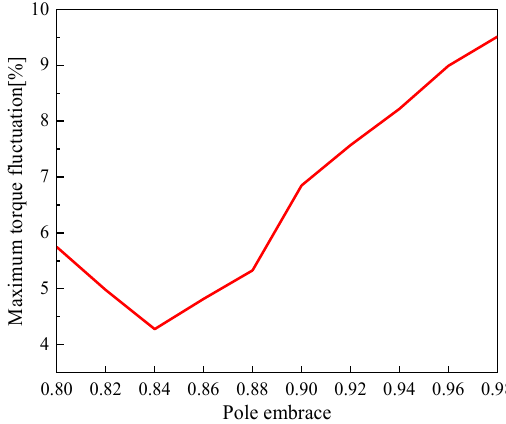
through parameter scanning and output torque simulation verification. Figure 13 shows the relationship between the polar arc coefficient and torque ripple. When the polar arc coefficient is 0.84, the corresponding torque volatility is 4.28%. At this point, the cogging torque is the minimum value.